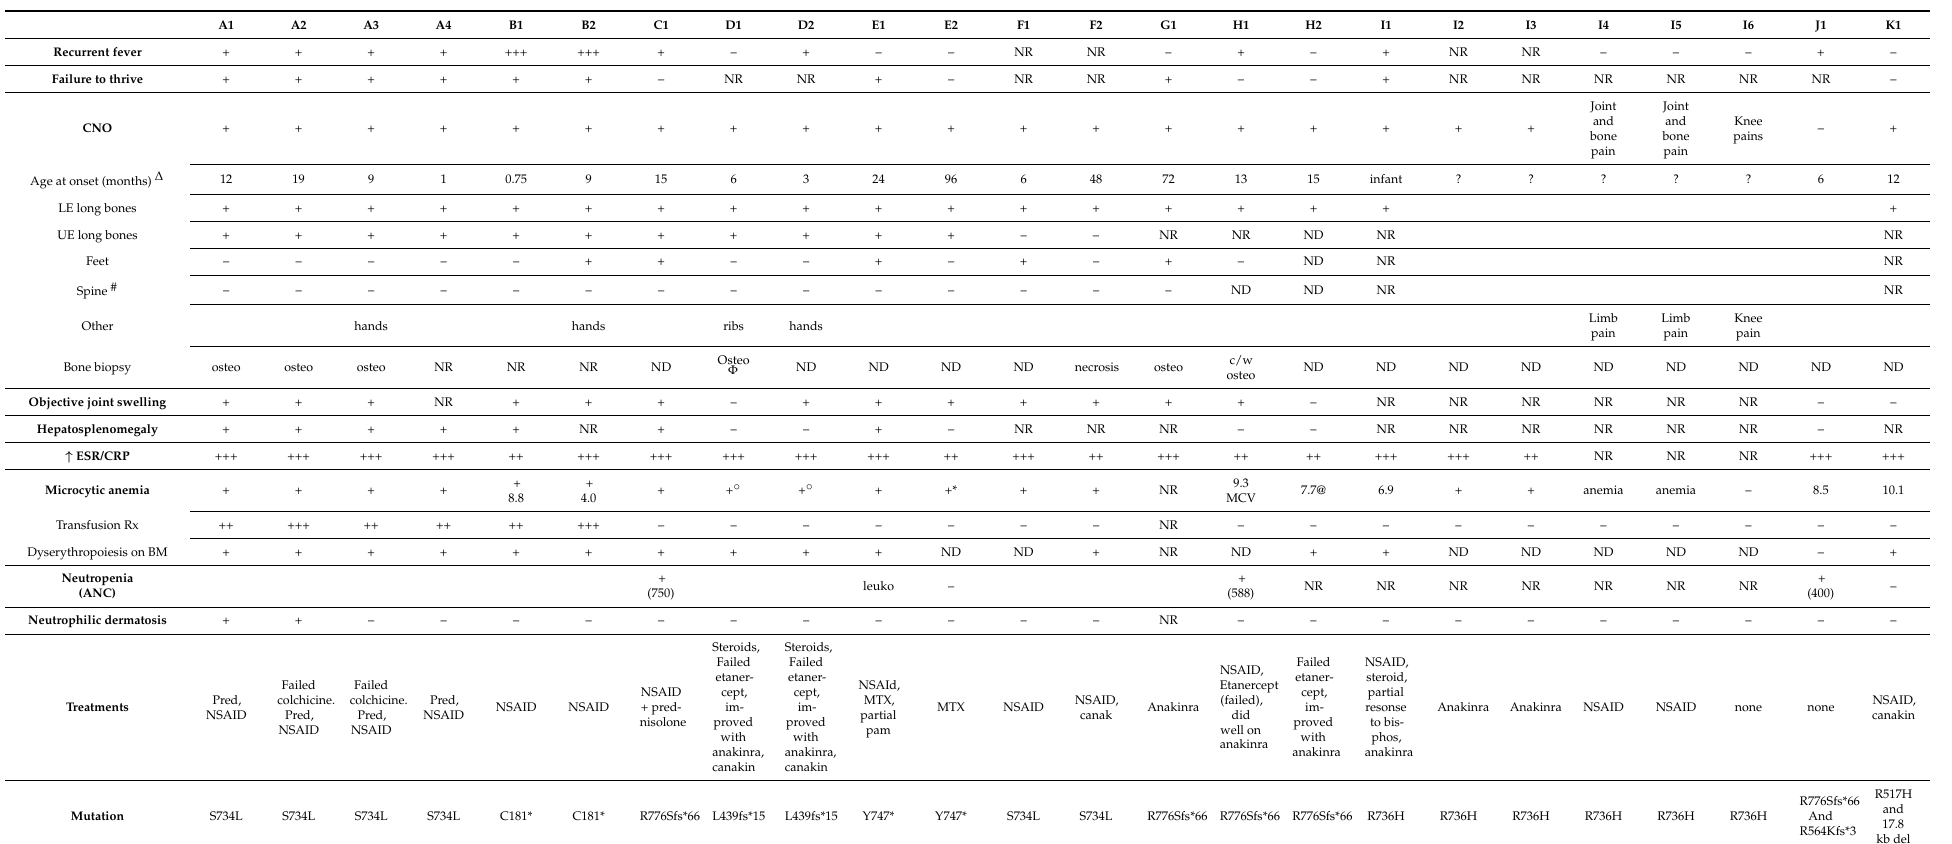
Table 1. Clinical features in Majeed